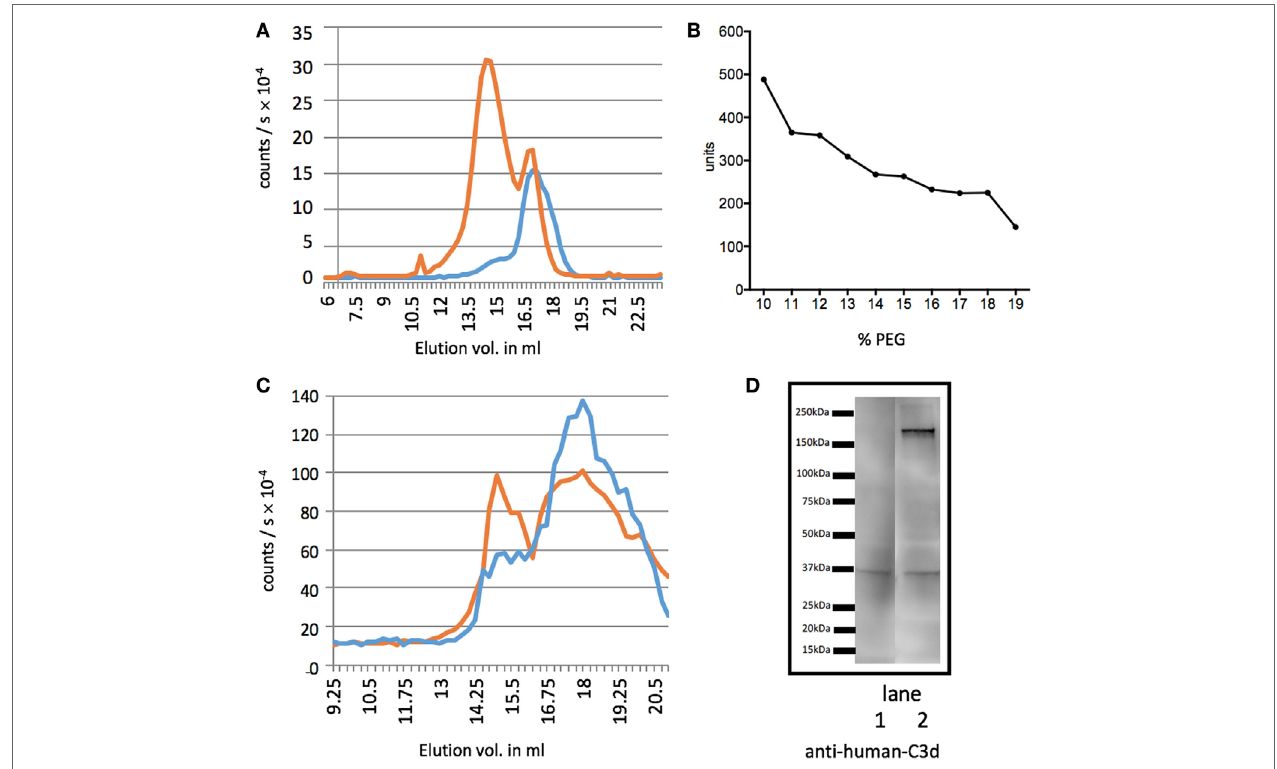
FigUre 1 | Separation of C3dg from the larger C3 fragments. Measurements of C3 molecules encompassing the determinants of the segment C3dg, i.e., C3 and all degradation molecules containing this part of C3. (a) The figure illustrates C3dg measurement on gel permeation chromatography (GPC) fractions of serum before activation (red line) and supernatant of polyethylene glycol (PEG)-precipitated activated serum (blue line). (B) Test for the optimal concentration of PEG for precipitation. Increasing concentrations of PEG were added to EDTA plasma and C3dg was estimated in the supernatants. (c) GPC of supernatant after precipitation of EDTA plasma with 11% (red) and 16% (blue) PEG. C3dg in the fractions was measured. The 11% supernatant shows two major peaks, the first corresponding to C3 and larger C3 components, and the second corresponding to free C3dg. After precipitation with 16% PEG the first was significantly reduced. Panel (D) shows the results of western blotting of supernatants of EDTA-plasma precipitated with 16% (lane 1) or 11% (lane 2) PEG. The samples (corresponding to 0.1 µl plasma) were run non-reduced on the SDS-PAGE. The blot was developed with anti-C3d antibody. It can be seen that the 11% PEG supernatant still contains appreciable amounts of larger C3dg-encompassing molecules. This was repeated three times with similar